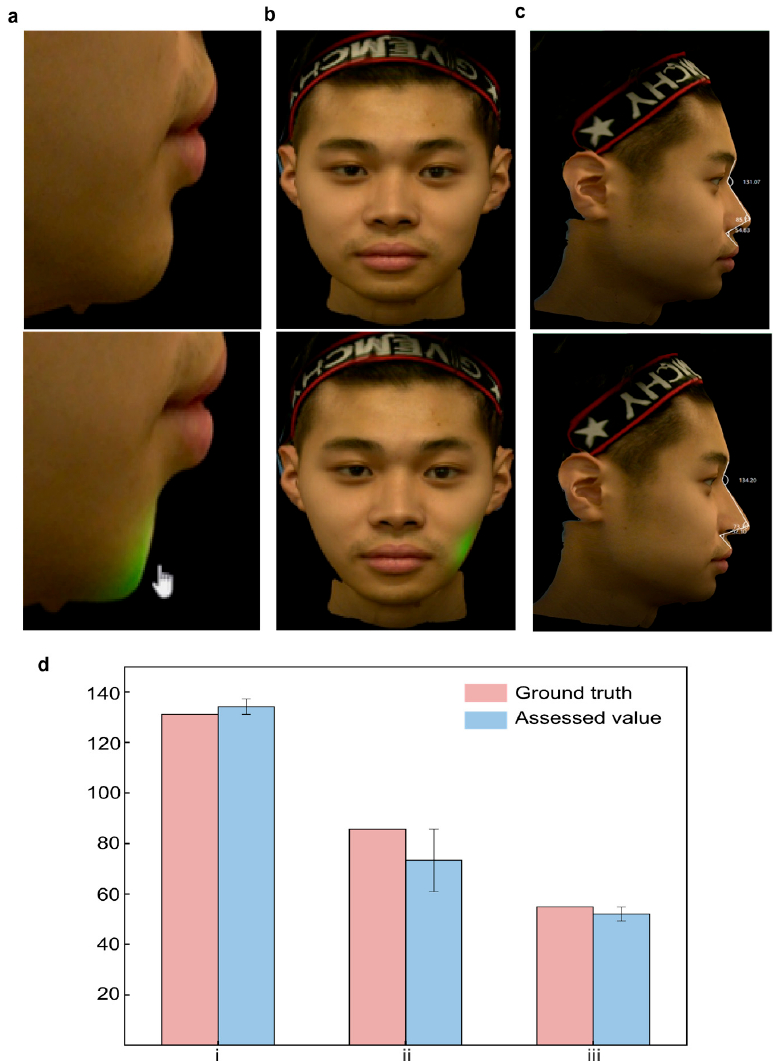
Figure 4. The simulated surgery. ( a ) chin. ( b ) mandible. ( c ) nose. ( d ) value of nose adjustment.